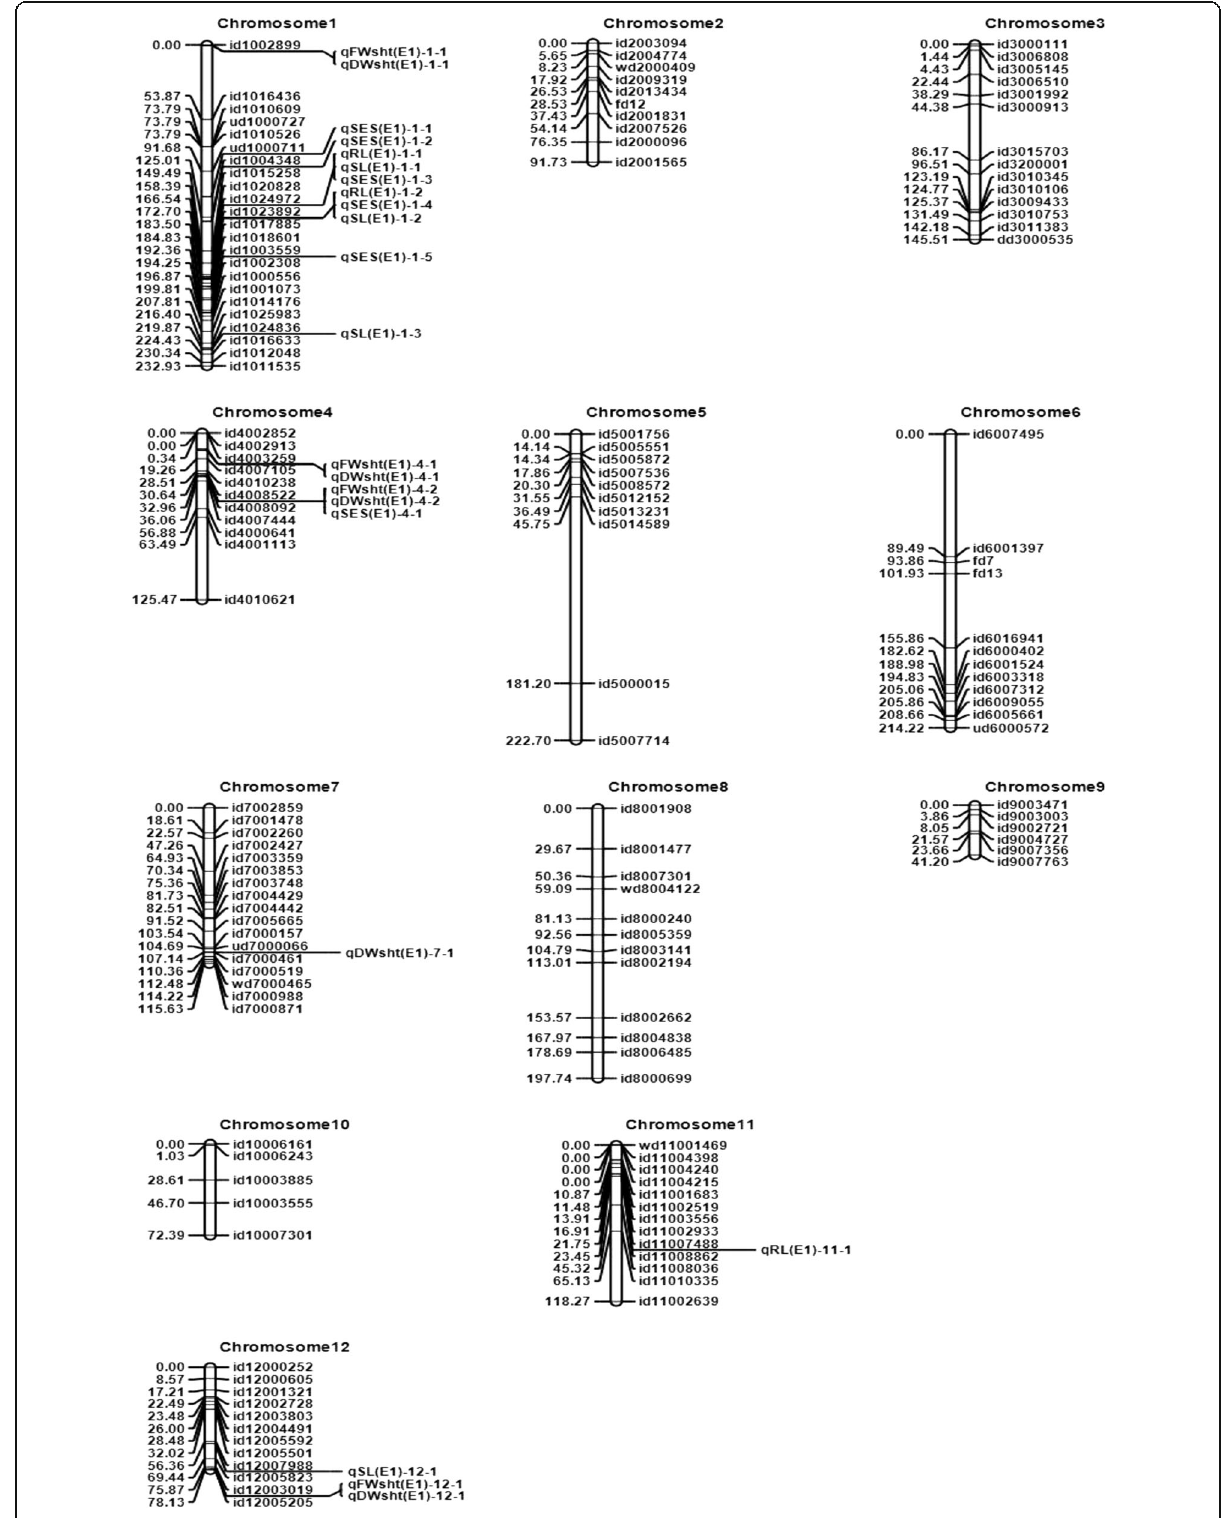
Fig. 1 Genetic linkage maps of the 12 chromosomes constructed using ordering algorithm (RECORD) based on an IR29/Hasawi RIL population phenotyped in the phytotron at IRRI (E1). The names of the SNP markers with position are listed to the right and the approximate locations of the QTLs detected for salinity tolerance are shown to the left of the